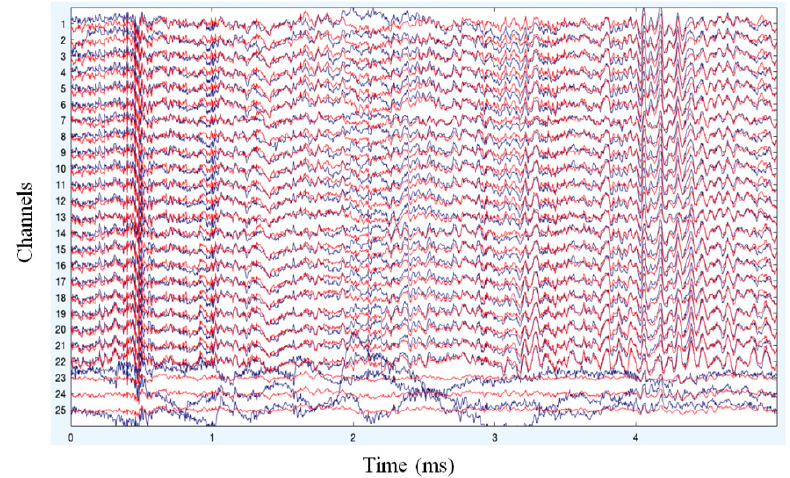
Figure 7. Pruned data after artifact removal.